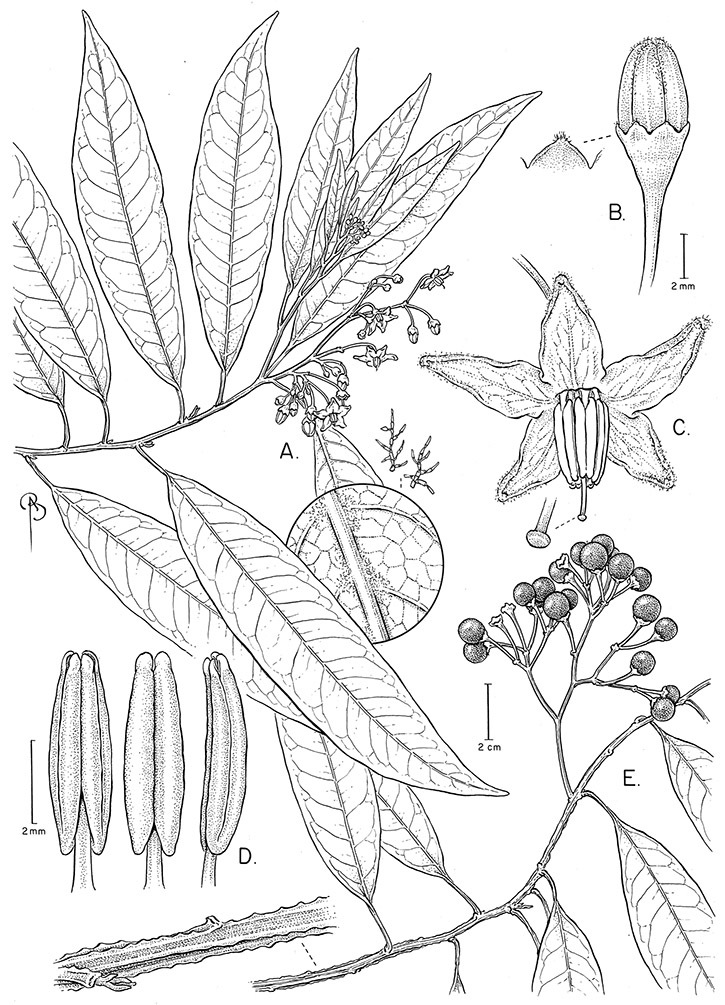
Solanum aligerum Schltdl. (A drawn from Martinez S. 4741
B–D drawn from Torres B. 2022
E drawn from Nee 26870). Illustration by Bobbi Angell.